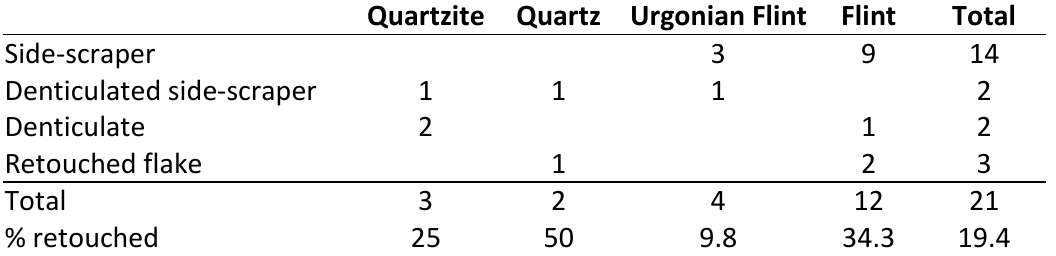
Table 2. Typological composition of Ventalaperra's level III (depth between -45 and -70 cm), Barandiarán and Aranzadi's collection.